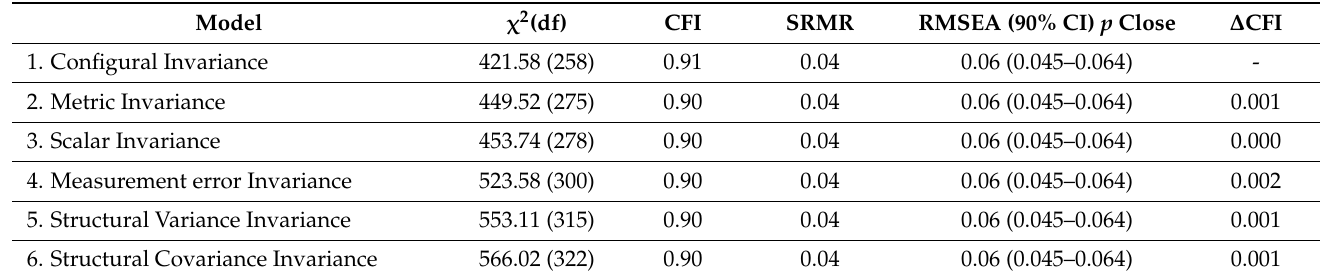
Table 5. Fit statistics for measurement invariance by gender.